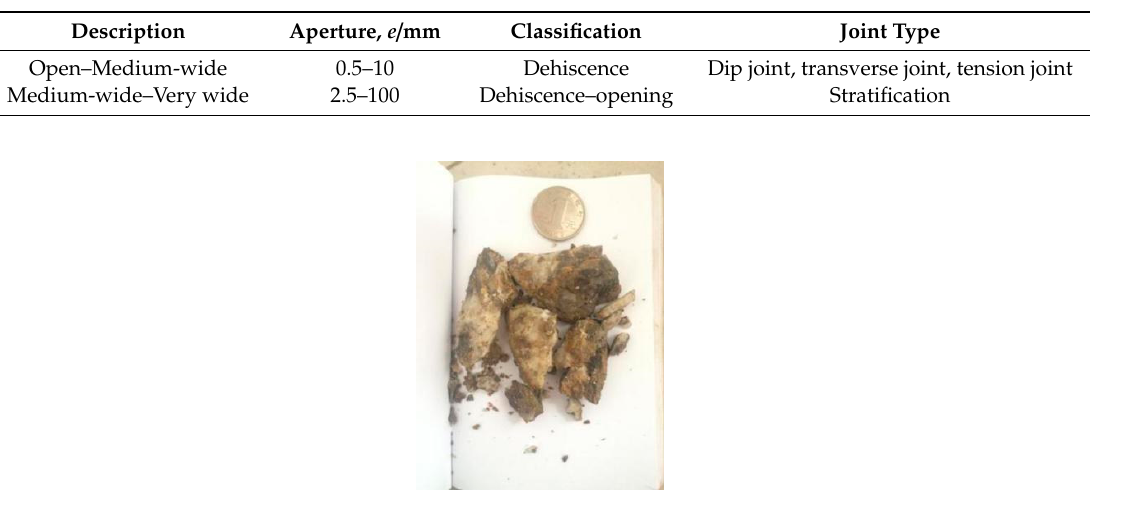
Table 1. Aperture grade of joints.